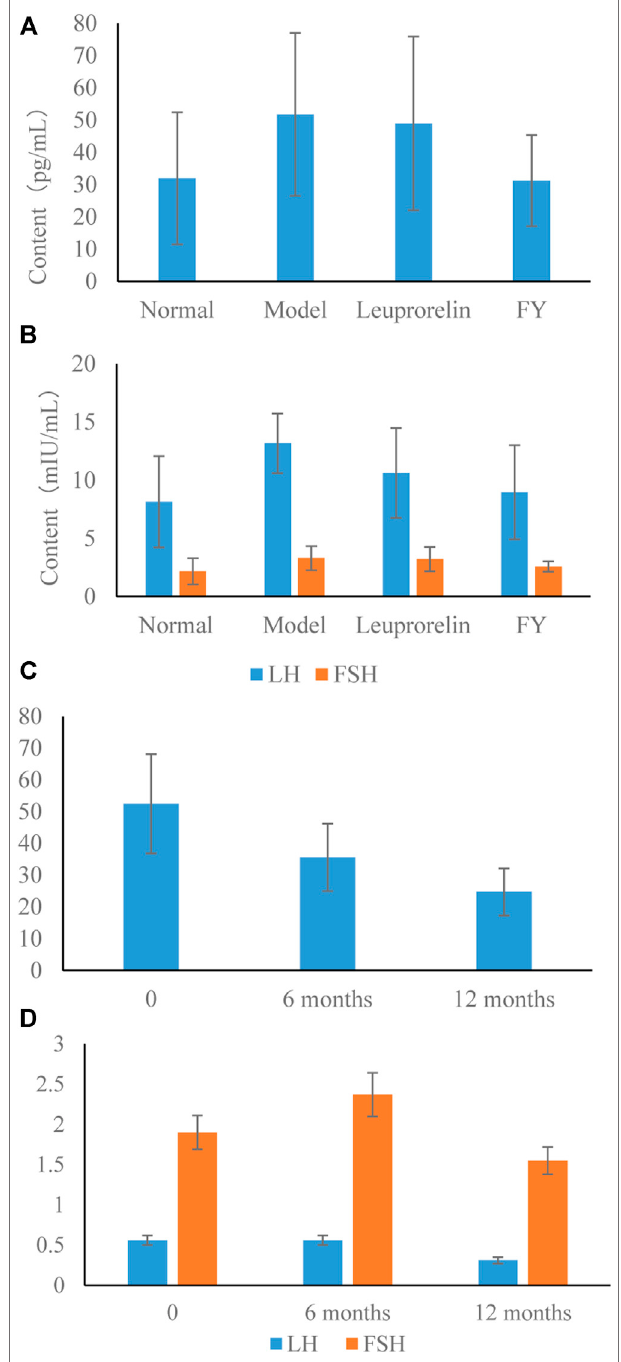
FIGURE 4 | Effects of the FY on sex hormone levels in PP. (A) Serum estrogen (E 2 ) levels among all groups of rats. (B) Serum luteinizing hormone (LH) andfollicle-stimulatinghormone(FSH)levelsamongallgroupsofrats. (C) Serum E 2 levels among all groups of children. (D) Serum LH and FSH were detected among all groups of